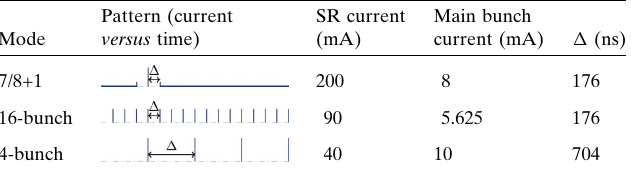
Table 1 ESRF filling modes and timings during HPLF-2018